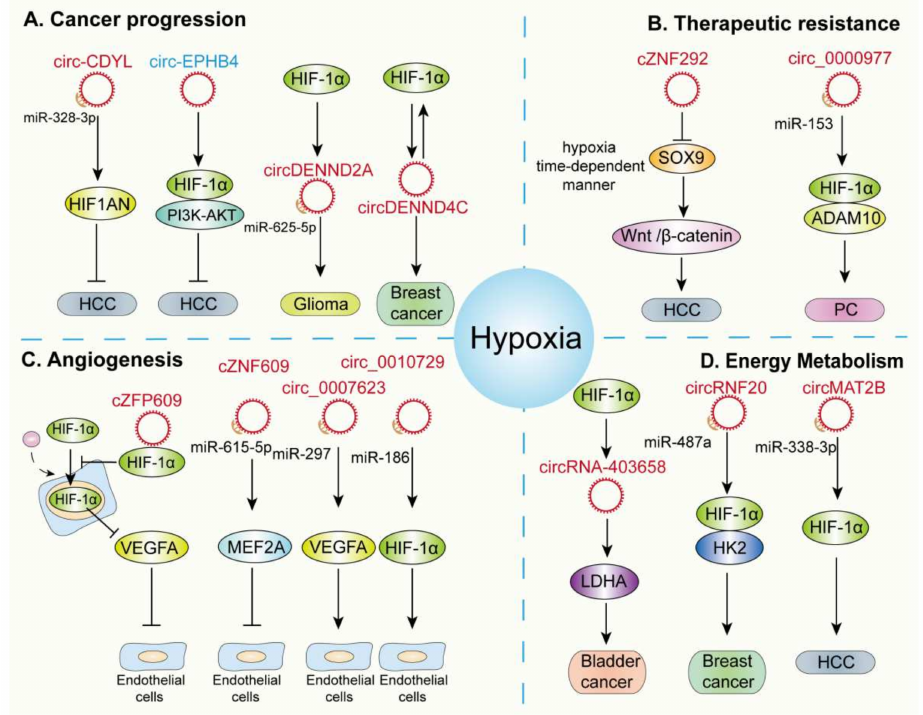
Figure 3. Functions of circRNAs in hypoxic microenvironments. ( A ) circRNAs mediate cancer progression under hypoxia. ( B ) circRNAs regulate therapeutic resistance. ( C ) Hypoxia-induced circRNAs control angiogenesis. ( D ) Hypoxia-induced circRNAs influence energy metabolism. The upregulated circRNAs are in red, whereas the downregulated circRNAs are in